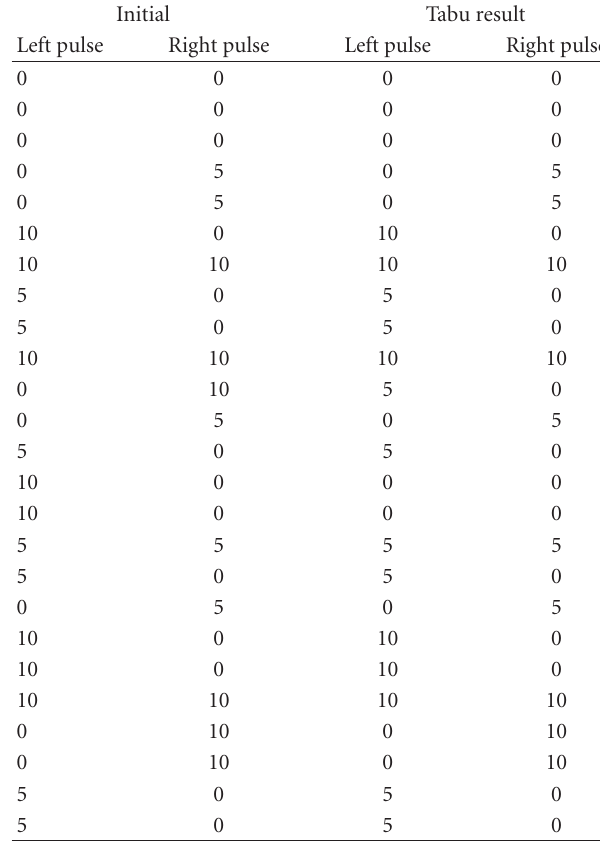
Table 2: Tabu method results for the random